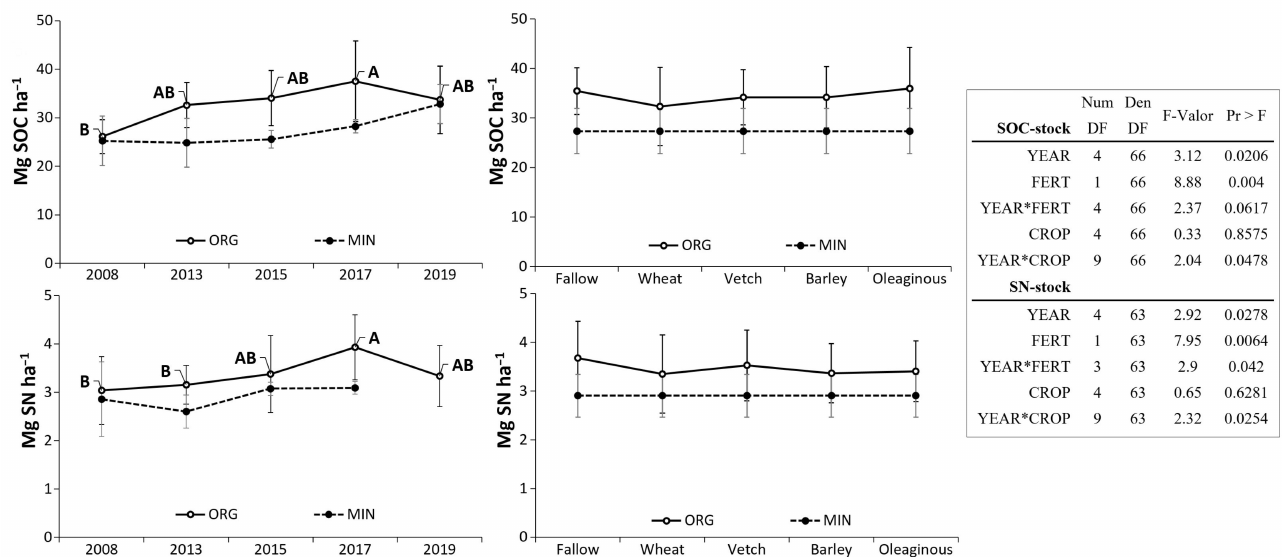
Figure 5. Influence of Year and Crop on the stocks of SOC and SN under ORG compared to the MIN treatment. Bars indicate the standard deviation of the data. Uppercase letters indicate that means are significantly different among years and lowercase letters indicate that means are different between management practices ( p < 0.05). Analysis of variance (PROC MIXED) for evaluating YEAR, fertilization (FERT) and CROP influences on soil organic matter (SOC). The interaction FERT*CROP lacked Degrees of Freedom for the